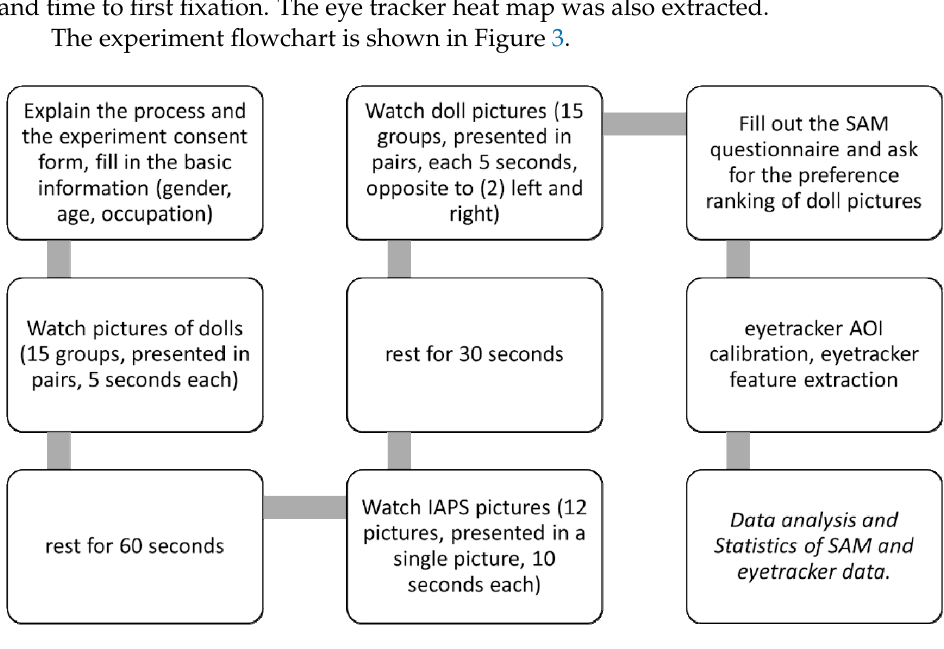
Figure 3. Experiment flowchart.